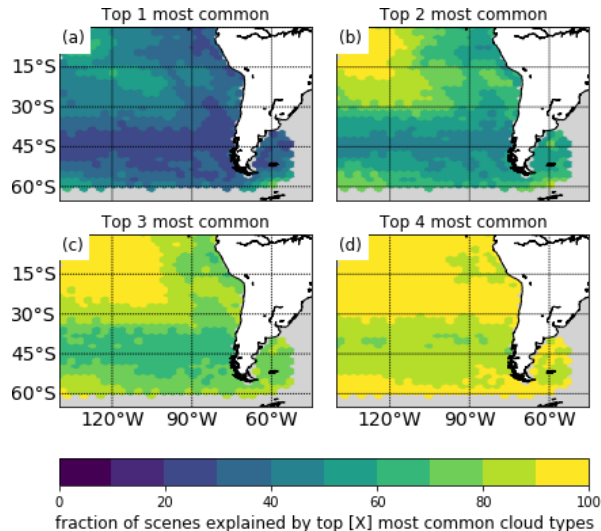
Figure 6. The fraction of cloud scenes for each grid point, which are represented by (a) the most common cloud type for that grid point and (b–d) the top two through top four most common cloud types. Gray areas indicate that fewer than 200 scenes were